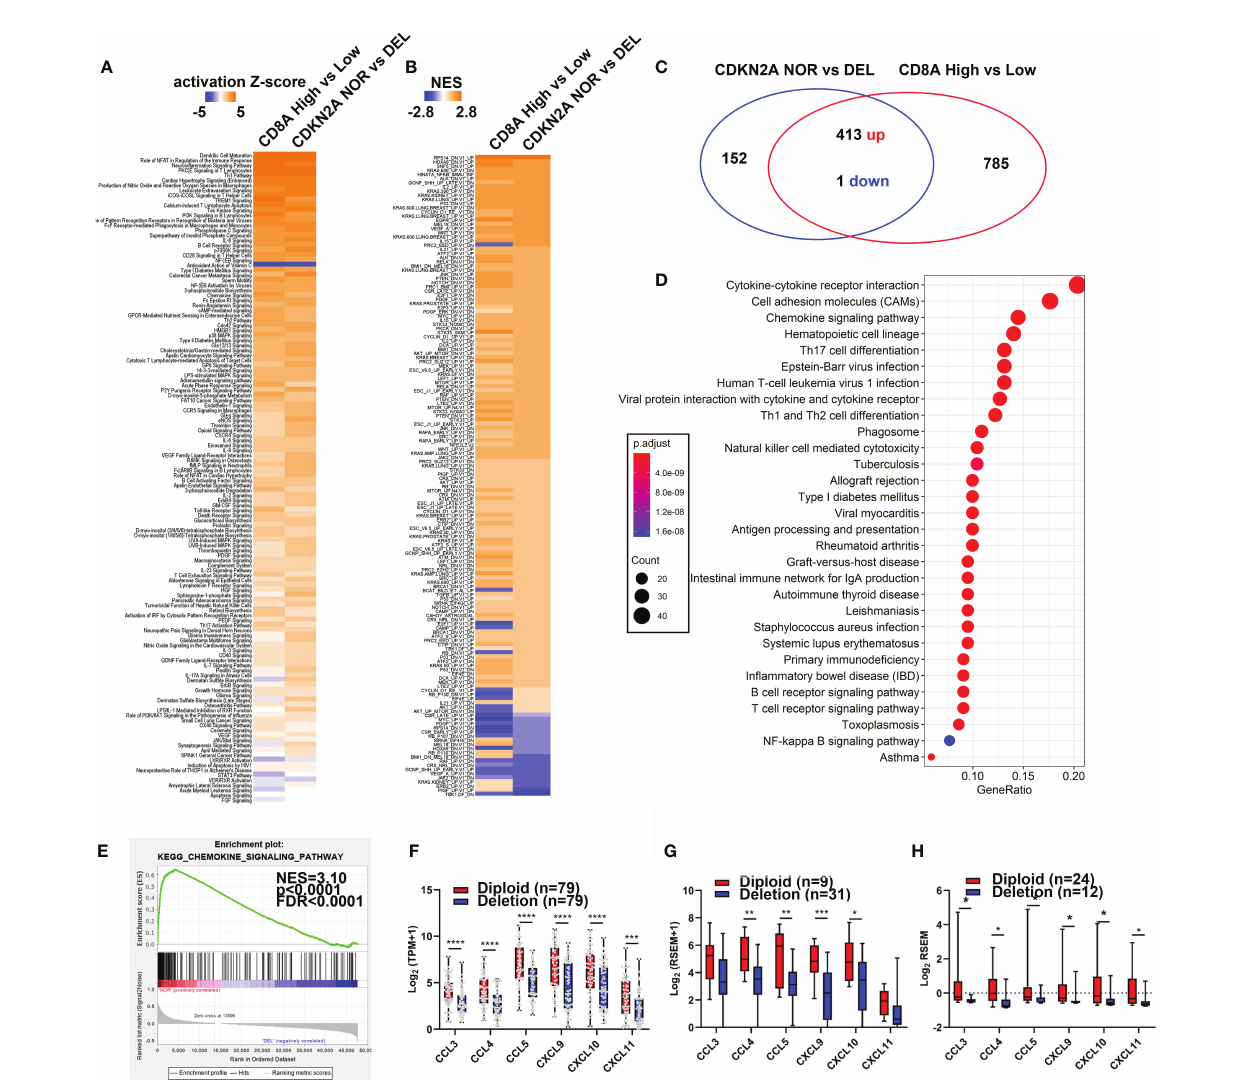
FIGURE 2 | The patients with normal CDKN2A or high CD8A expression showed similar regulation of chemokine signaling pathway. (A, B) Heatmap analysis of the pathway enrichment partem of the differentially expressed genes in CD8A high/low groups (From Figure 1 ) and CDKN2A NOR (diploid, n = 79) and DEL (Deep deletion, n = 79) in IPA analysis (A) and C6 oncogenic pathway GSEA analysis (B) . (C) Venn diagram shows differentially expressed gene (DEG) number in CDKN2A NOR/DEL group and CD8A High/Low group. (D) KEGG analysis of common regulated gene in CDKN2A NOR/DEL and CD8A HIGH/LOW group. (E) GSEA analysis of the chemokine signaling pathway expression in CDKN2A NOR/DEL group. (F) The expression of known T-cell recruitment chemokines expression in CDKN2A normal and deleted group in TCGA-melanoma cohort. (G) The expression of known T-cell recruitment chemokines expression in CDKN2A normal and deleted group in DFCI-melanoma cohort. (H) The expression of known recruitment chemokines expression in CDKN2A normal and deleted group in TGEN-melanoma cohort. *p < 0.05, **p < 0.01, ***p < 0.001, ****P <